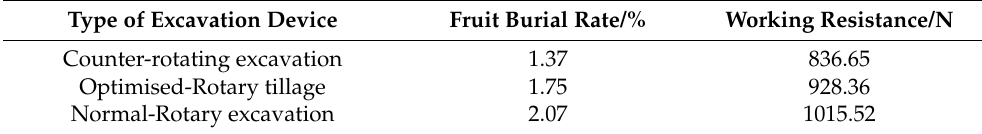
Table 10. The results of field trial results